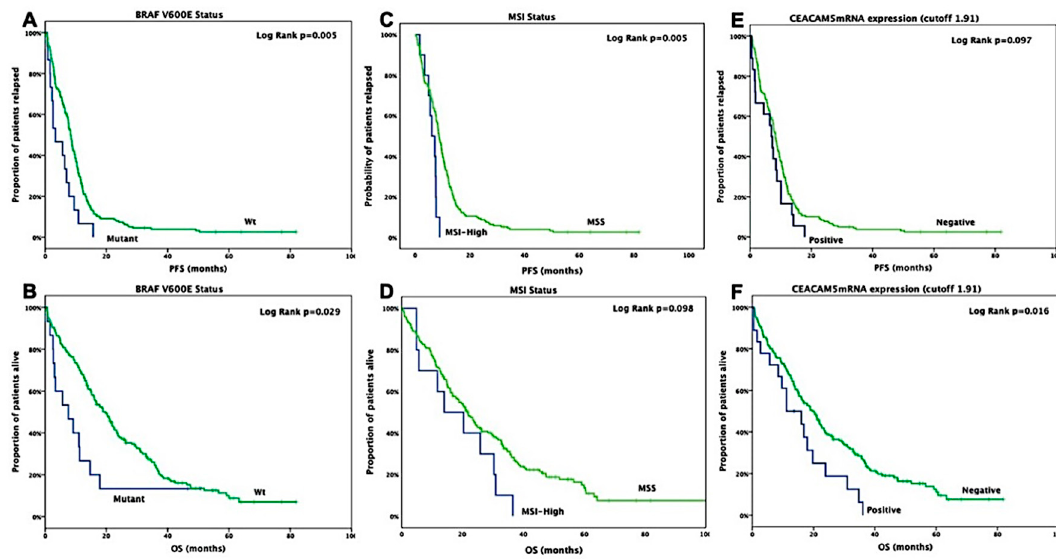
Figure 1. Kaplan Meier curves for progression-free and overall survival according to BRAF V600E ( A , B ), microsatellite instability ( C , D ) and CEACAM5mRNA ( E , F ) status, respectively, in stage IV patients.